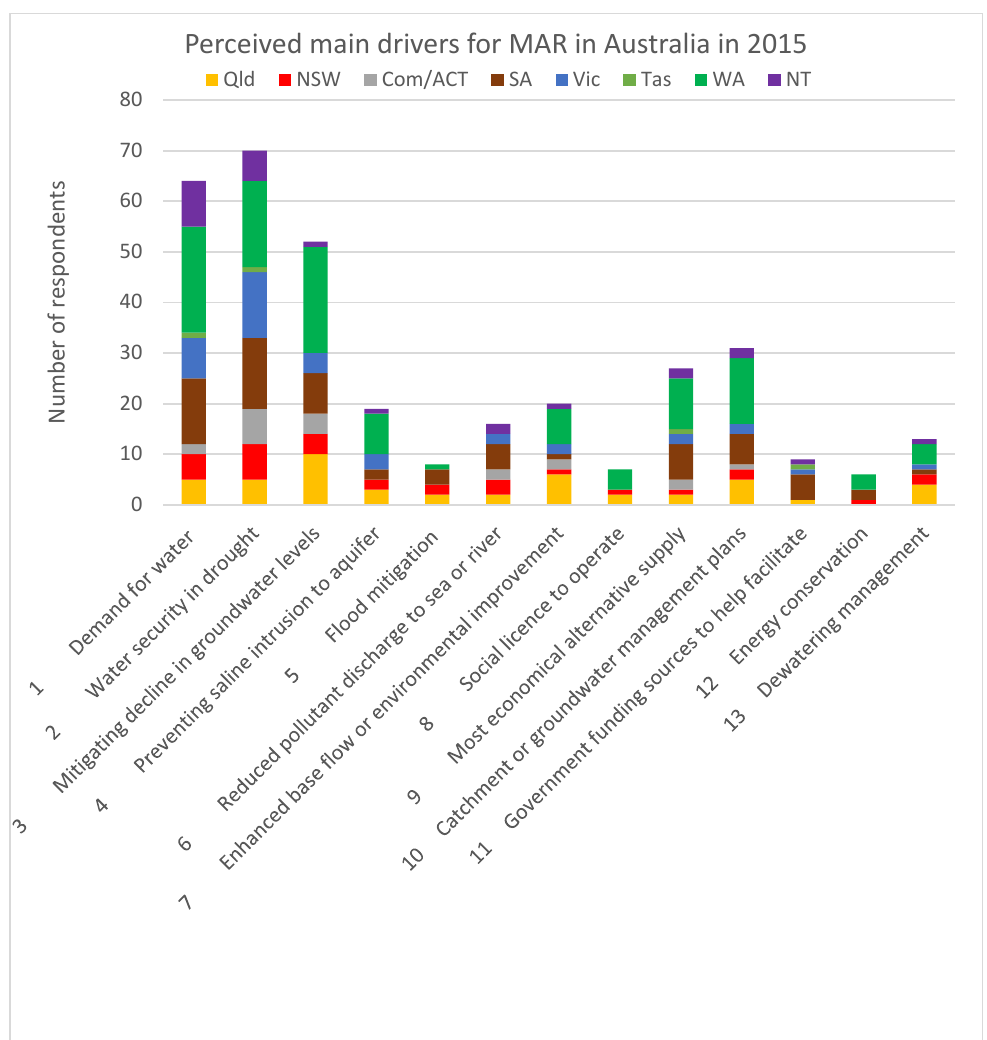
Figure 3. The main drivers for MAR perceived by 134 Australian respondents in a survey of the National Centre for Groundwater Research and Training (NCGRT) May–July 2015. This shows the number of respondents reporting perceived importance of each identified factor driving the development of MAR in their jurisdiction. (Total number of respondents = 134, total responses = 342, and average number of responses per category = 26.) (Also reported in supplementary info to [27].)